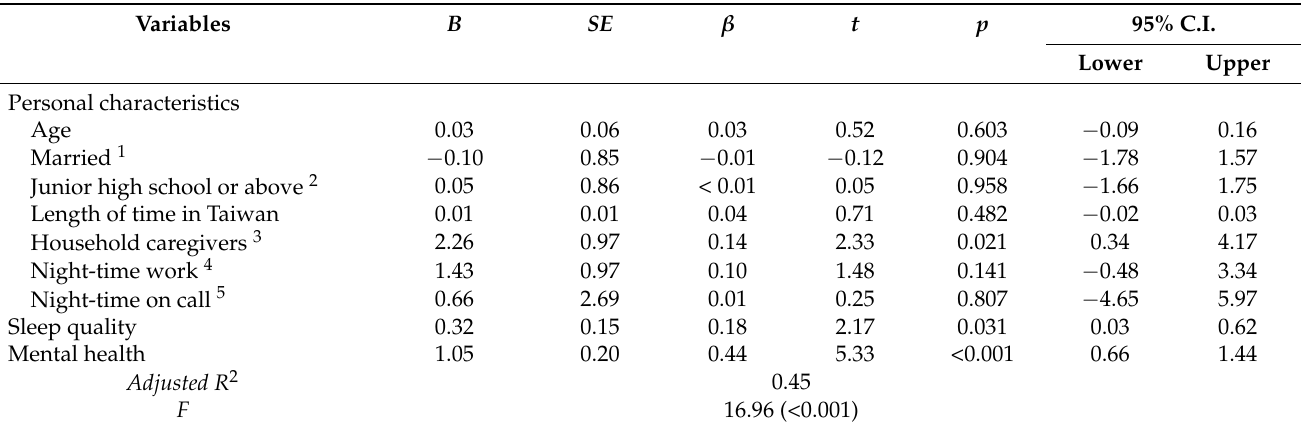
Table 3. Analysis of the impact of personal characteristics, sleep quality, and mental health on workplace bullying among Indonesian caregivers ( N =